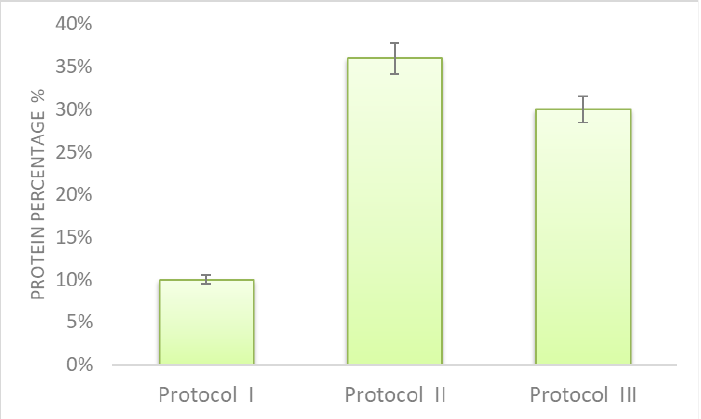
Figure 2. Protein recovery percentage obtained by applying three different extraction protocols. Evaluation was carried out by BCA assay, using BSA as a standard.